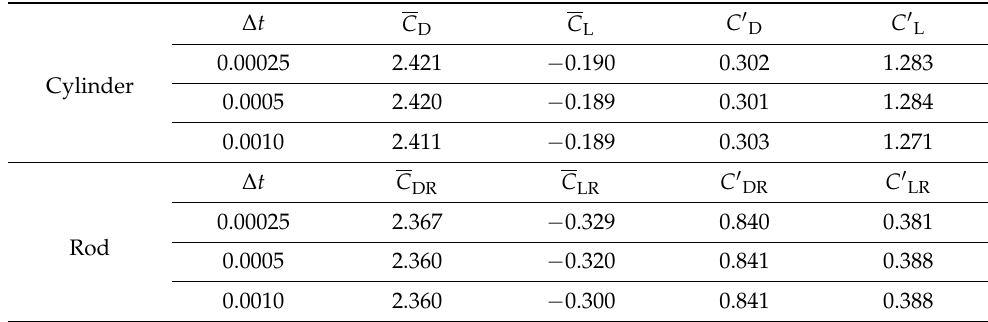
Table 2. Statistical values of the drag and lift coefficients in the time-step dependency study for β = 90 ◦ and α =